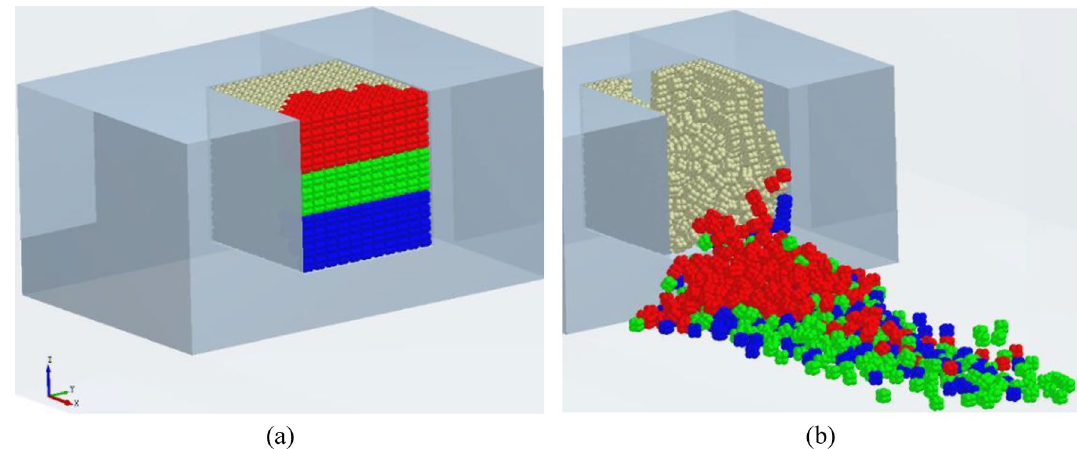
Figure 18. Layered accumulation of blocks (0.8